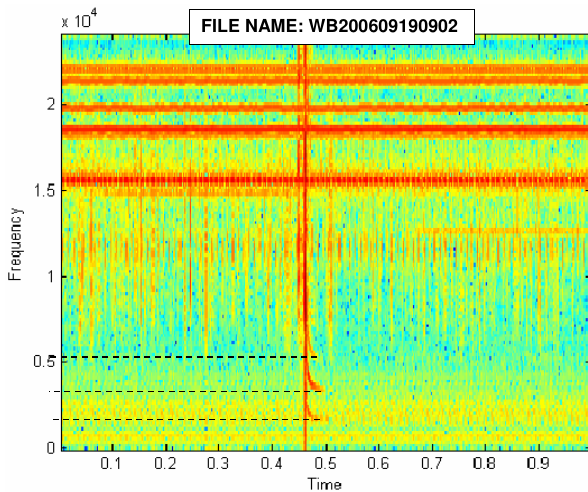
Figure 7. Spectrogram showing tweeks. Fig. 7. Spectrogram showing tweeks.